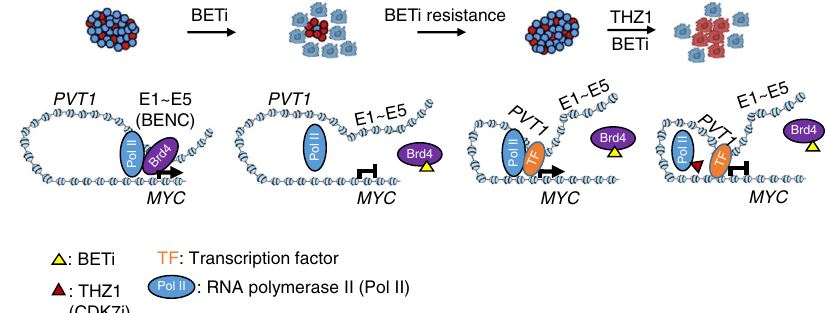
Fig. 8 A tentative enhancer remodeling model to explain the synergistic effect of BETi and THZ1 on BETi-resistant leukemia. MYC expression is regulated by the classic super-enhancer BENC (E1-E5) in BETi-sensitive leukemia cells, which is mediated by BRD4 binding. BETi blocks the BRD4 binding to its genomic targets and subsequently inhibits the expression of MYC and cell growth. Long-term drug treatment or primary resistance may restore MYC expression by enhancer remodeling: PVT1 acts as a de novo BRD4 binding-independent enhancer, which can recruit other transcription factors and RNA Polymerase II (Pol II) to the MYC promoter and initiate MYC expression. THZ1 treatment reduces the Pol II occupancy to suppress the re-activated